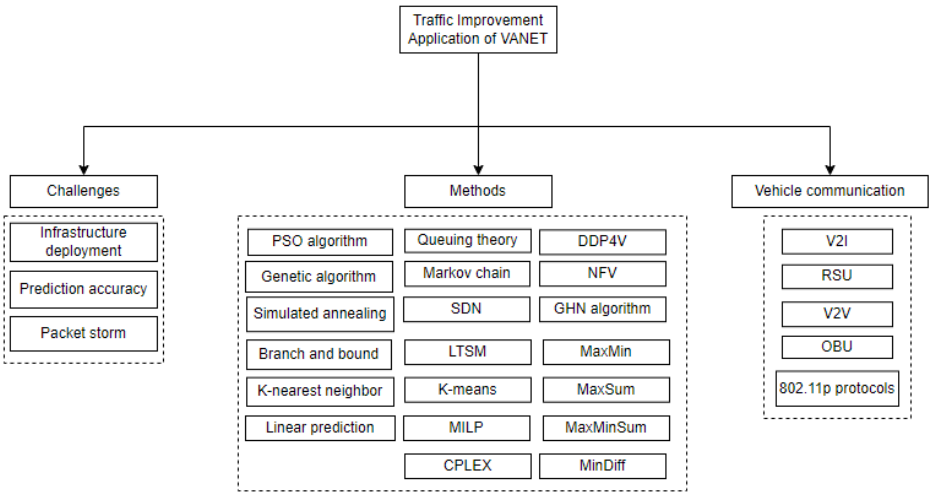
Figure 6. Operation of traffic improvement